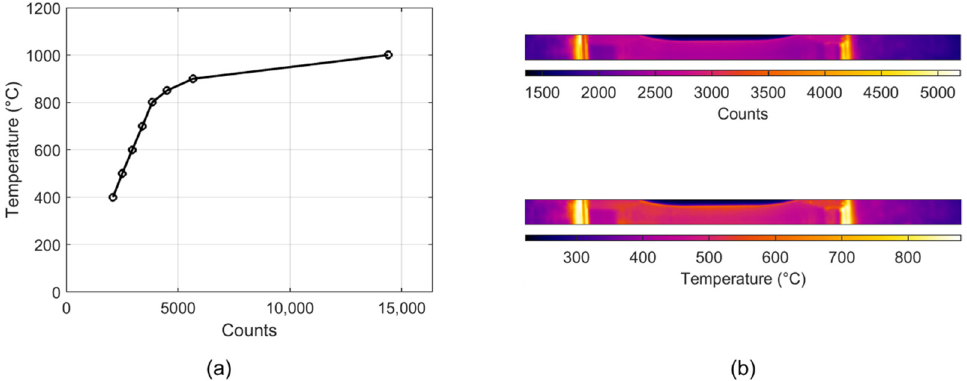
Figure 4. Infrared camera calibration procedure: ( a ) the relationship used for the calibration of the raw data coming from the infrared camera based on the local measurements performed with thermocouples and the infrared pyrometer; ( b ) the application of the conversion law for the calibration of the thermal images obtained on a test performed at 500 °C.